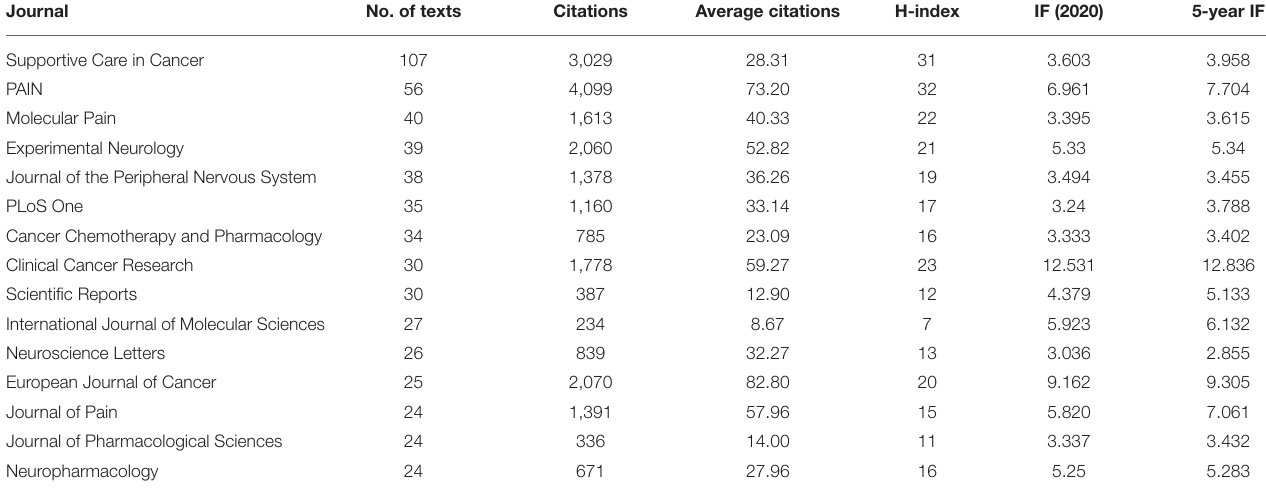
TABLE 3 | The top 15 most productive journals between 2001 and